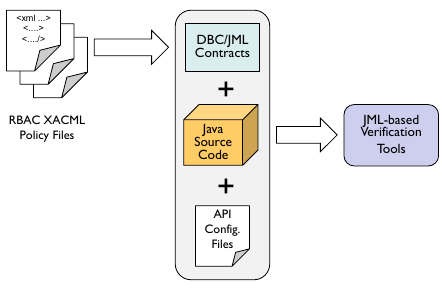
Figure 6. A FrameworkforAssertion-basedSecurity